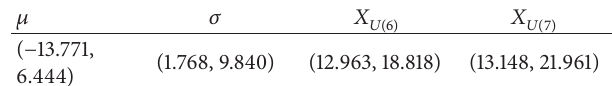
Table 2: Results for real